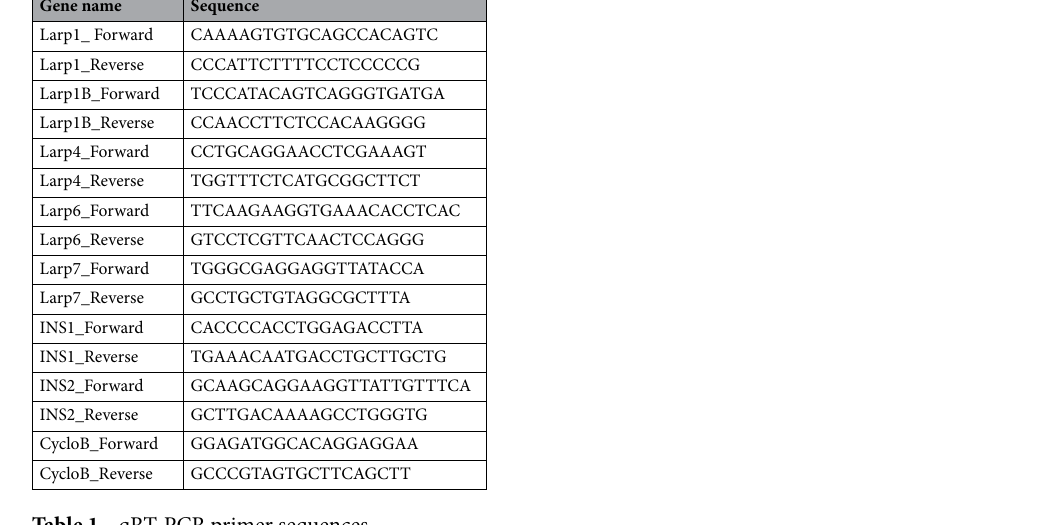
Table 1. qRT-PCR primer